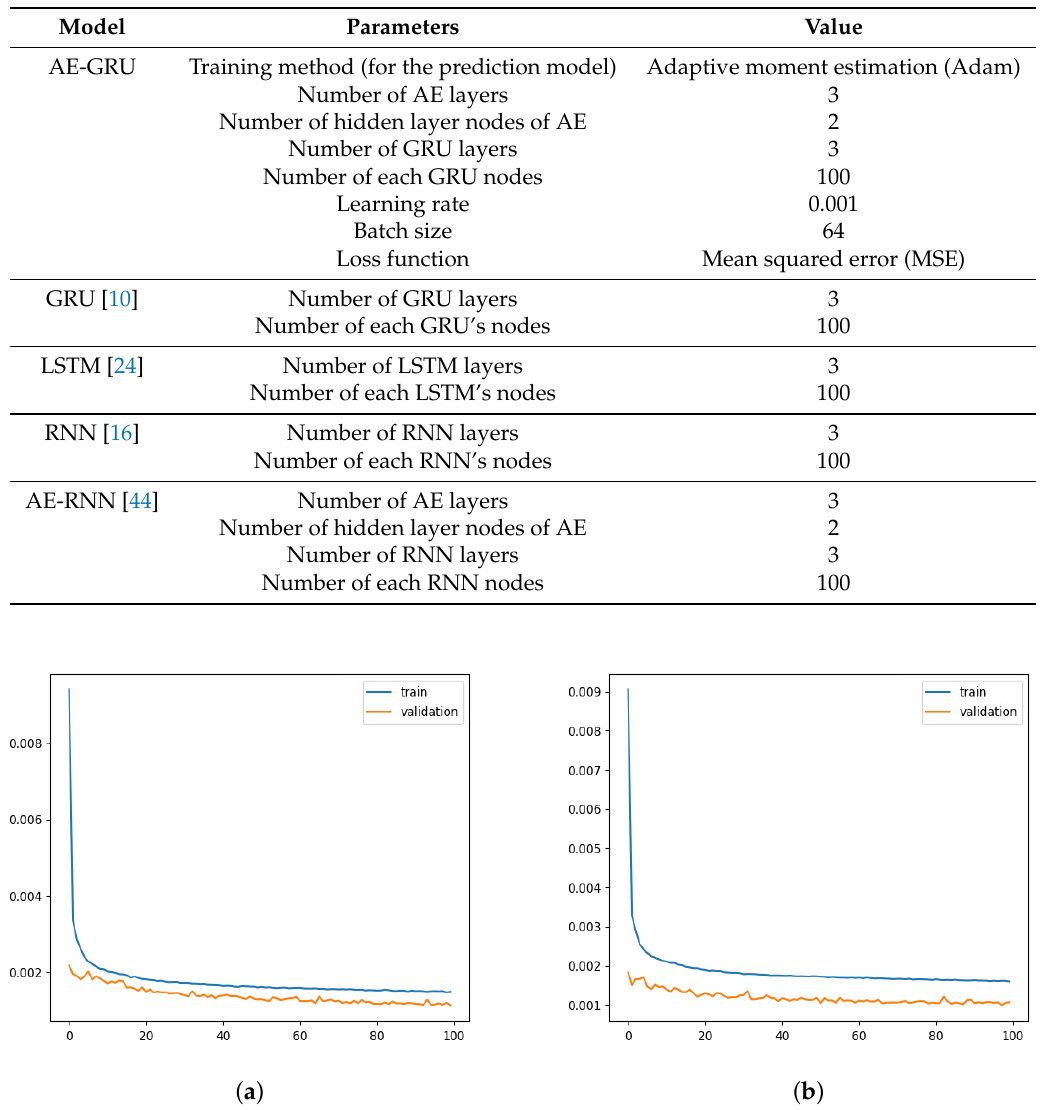
Table 3. The training parameters of each deep learning model.